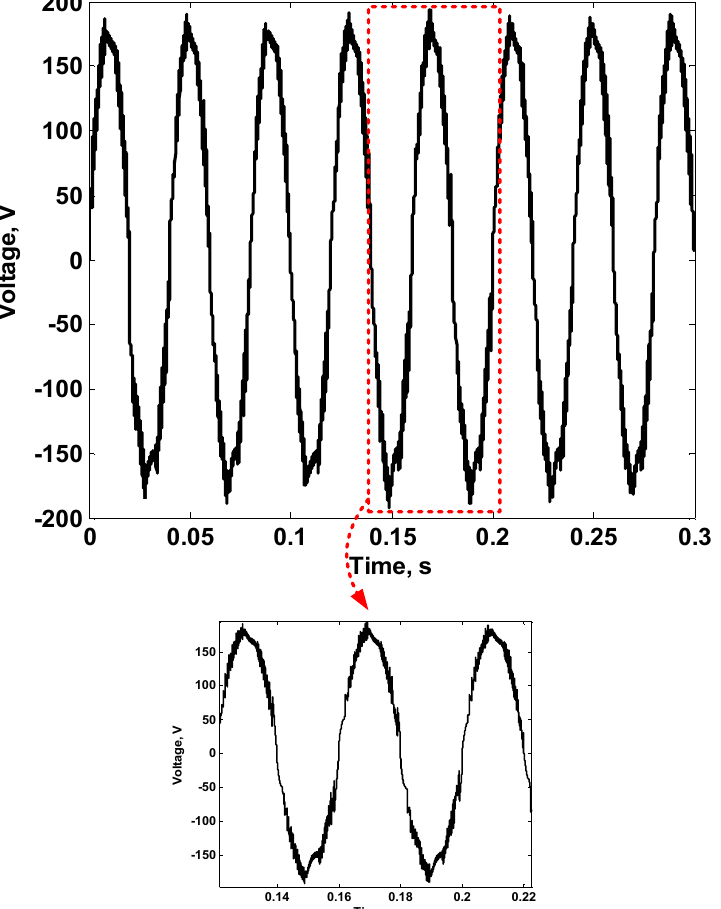
Figure 13. Conditions of 110 V, 25 Hz Sinusoidal Output Voltage.